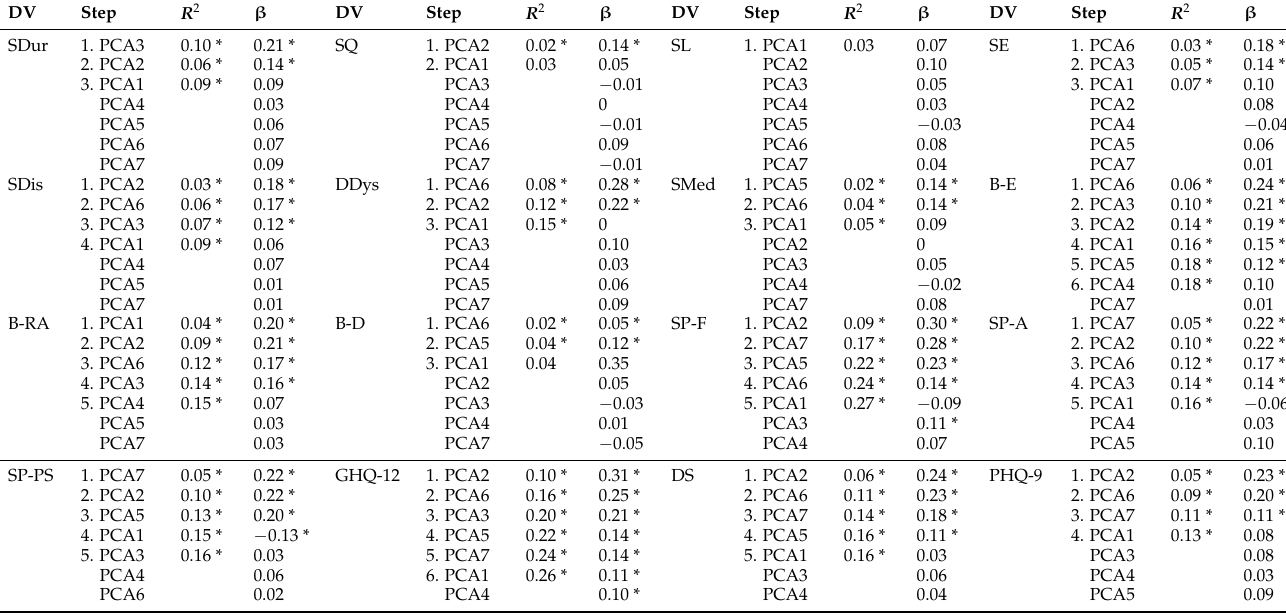
Table 2. Hierarchical regression analyses: Effects of stressors on outcome variables.